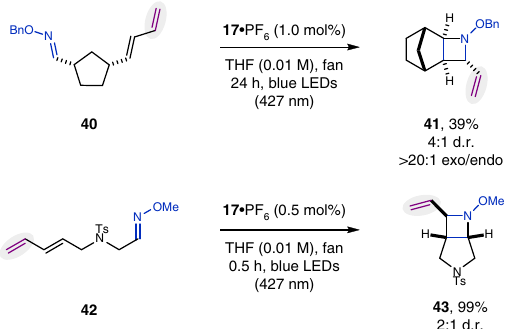
Fig. 4 Aza Paternò – Büchi reaction utilizing dienes. Reactions were performed with 0.25 mmol substrate; diastereomeric ratios (d.r.) were determined by 1 H NMR from the crude reaction mixture; isolated yields refer to the mixture of diastereomers (major diastereomer is given)